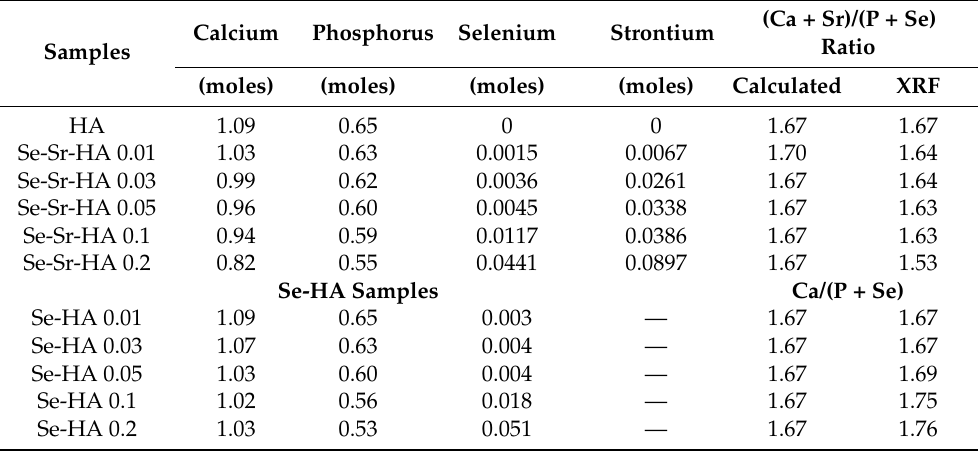
Table 2. Expected and measured elemental composition of HA, Se-HA, and Se-Sr-HA samples at different Se and Se/Sr molar ratios after sintering at 900 ◦